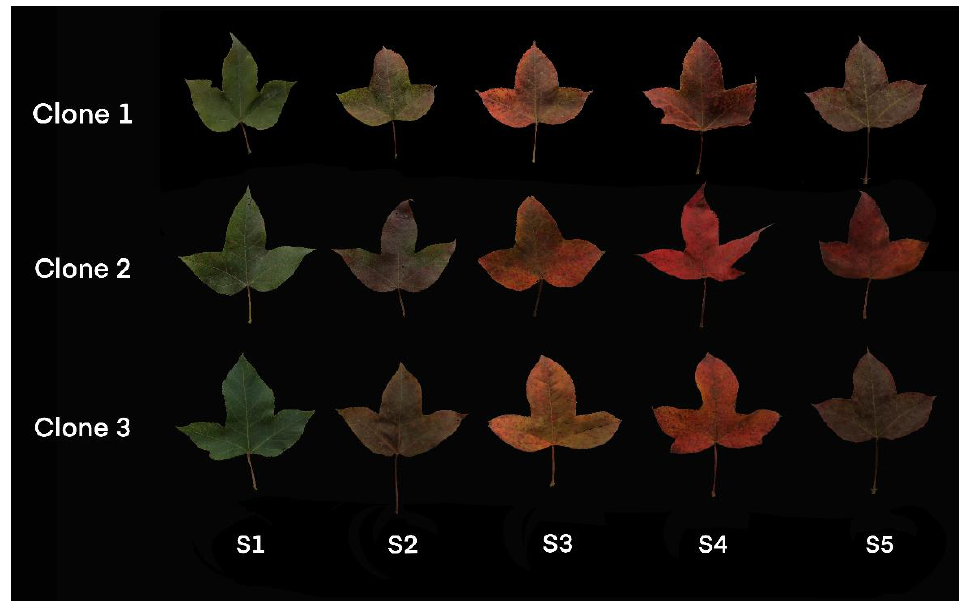
Figure 7. Different leaf colors of L. formosana at the five developmental stages.